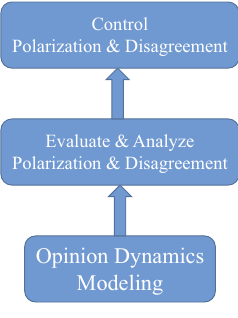
Evaluate & Analyze Polarization Opinion Dynamics Modeling